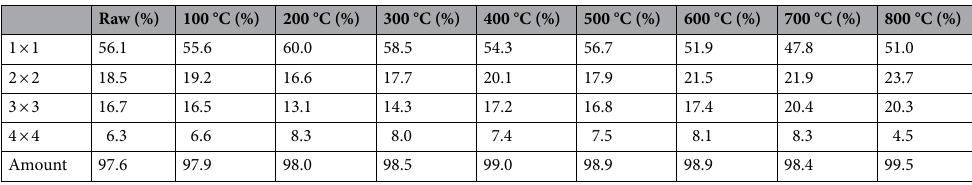
Table 2. Percentage of different aromatic sheets at different